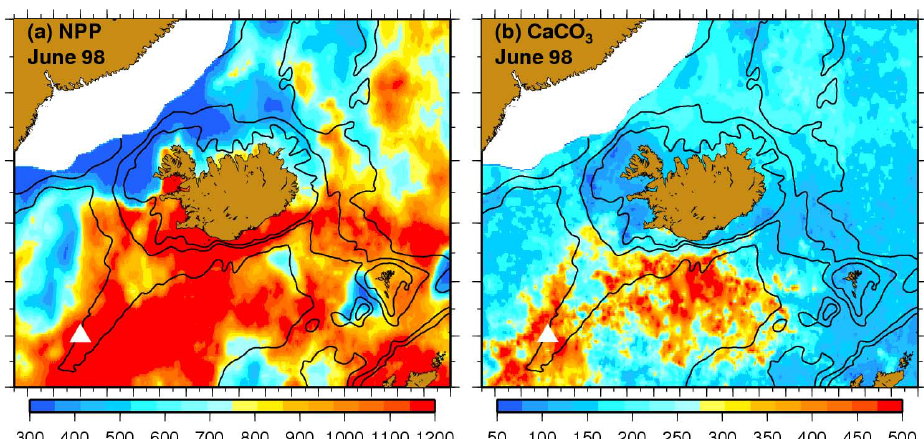
Fig. 5. Satellite-derived net primary production (a) and calcification rate (b) for June 1998 (units in mg C m − 2 d − 1 ) . The white triangle indicates the position of the 1-D ecosystem-carbon model simulations. Ice concentrations greater than 10% are masked in white.